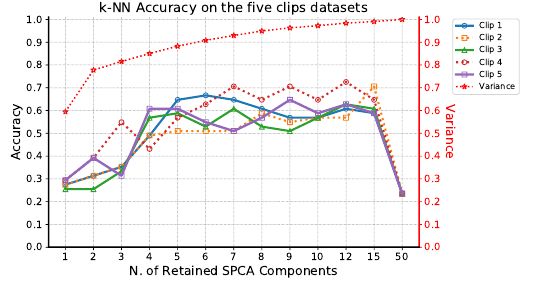
( a ) Average accuracy obtained with k-NN on the five clips of ( b ) Average accuracy obtained with SVM on the five clips of UserWGaze dataset. UserWGaze dataset. Figure 11. Classification results on the five videos of UserWGaze dataset. Table 1. Tables of the average accuracy for each of the five clips in the UserWGaze dataset. ( a ) The performances of SVM and k-NN are compared using the first 9 SPCA components, which represent about 95% of the variance; ( b ) the results of the case with 50 SPCA components and the total are given. ( a